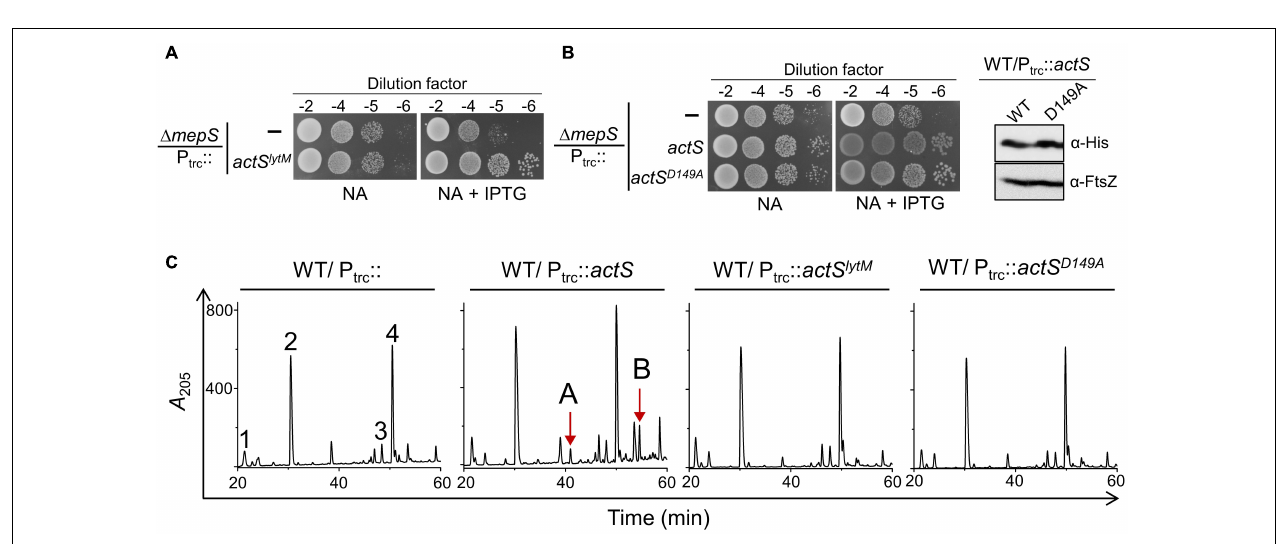
FIGURE 7 | Overexpression phenotypes of ActS variants. (A) Viability assay indicating the suppression of (cid:49) mepS phenotype by ActS LytM . (B) Viability assay indicating the suppression of (cid:49) mepS phenotype by ActS FL -His and ActS D149A -His (B.1). Western blot showing the expression of ActS WT -His and ActS D149A -His induced with 20 µ M IPTG (B.2). (C) HPLC chromatograms depicting the composition of PG of cells carrying either actS (P trc :: actS ), actS LytM (P trc :: actS LytM ) or actS D149A (P trc :: actS D 149 A ). Strains were grown to an OD 600 of ∼ 1 in LB containing 500 µ M IPTG followed by isolation and analysis of PG